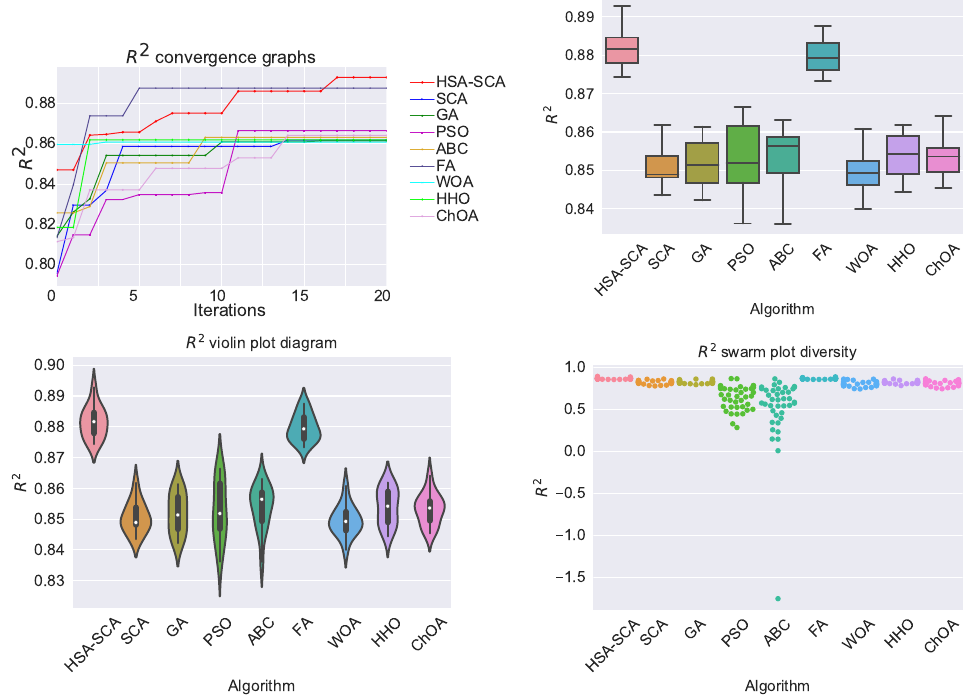
Figure 3. Visualized XGBoost results for all nine metaheuristics in terms of the convergence, box plot, violin diagrams, and swarm diversity plots for the R 2